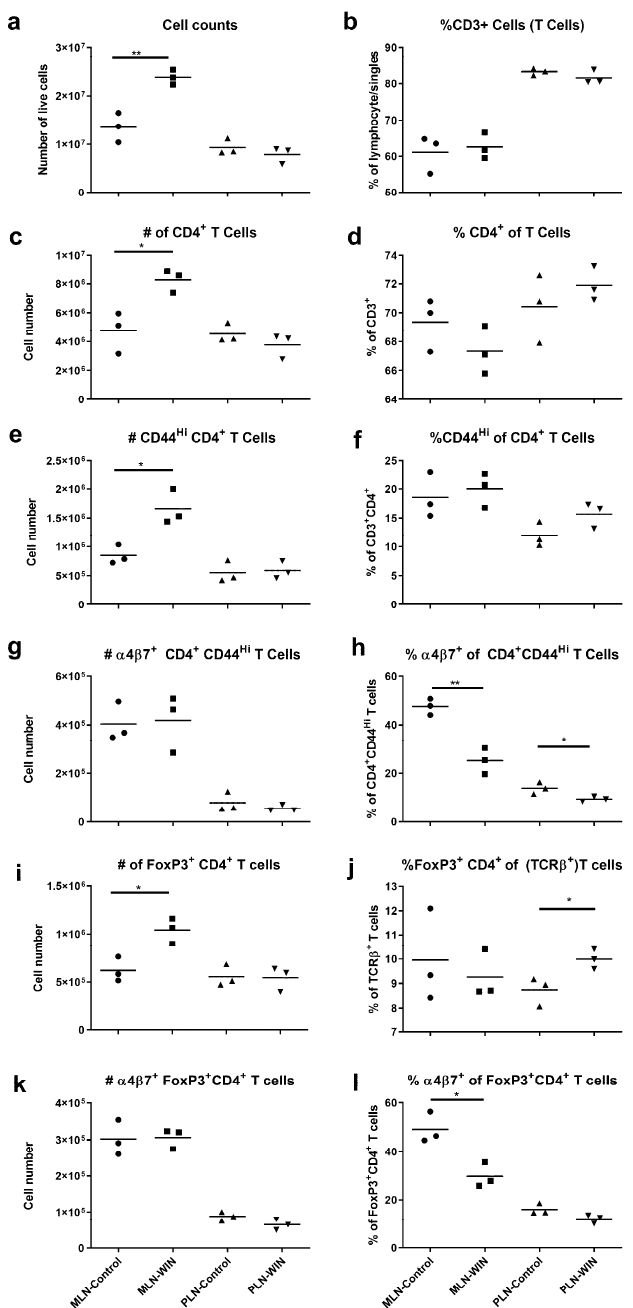
Figure 2. α 4 β 7 integrin expression is decreased in activated CD4 + MLN (mesenteric lymph node) T cells of WIN 18,466-treated (WIN) mice compared to controls. Cells from MLN and PLN of mice fed WIN 18,446-containing or control diets (N = 3 mice per group) for 3 weeks were stained with antibodies in two di ff erent stains (see also Table 1), ( a – h ) Stain 1 and ( i – l ) Stain 2, and evaluated using flow cytometry. ( a ) Total live cell counts (hemocytometer) of MLN and PLN preparations. ( b ) Percent CD3 + T cells. ( c ) Numbers of CD4 + CD3 + T cells. ( d ) Percent CD4 + of CD3 + T cells. ( e ) Numbers of activated (CD44 Hi ) CD4 + T cells. ( f ) Percent activated (CD44 Hi ) of CD4 + T cells. ( g ) Numbers of α 4 β 7 + activated CD4 + T cells. ( h ) Percent α 4 β 7 + of activated CD4 + T cells. ( i ) Numbers of Foxp3 + CD4 + T (TCR β + ) cells. ( j ) Percent Foxp3 + CD4 + of T cells. ( k ) Numbers of α 4 β 7 + Foxp3 + CD4 + T cells. ( l ) Percent α 4 β 7 + of Foxp3 + CD4 + T cells. * p < 0.05, ** p < 0.01, pair-wise comparisons via Student’s t -test or Mann–Whitney test. Note the di ff erent origin of y-axes in ( b , d , j ). Data shown are from one of two independent experiments. The second one is shown in Figure